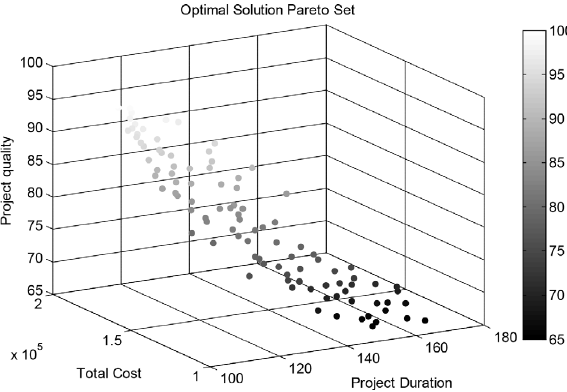
Fig. 7. Time-Cost-Quality trade-off Pareto front